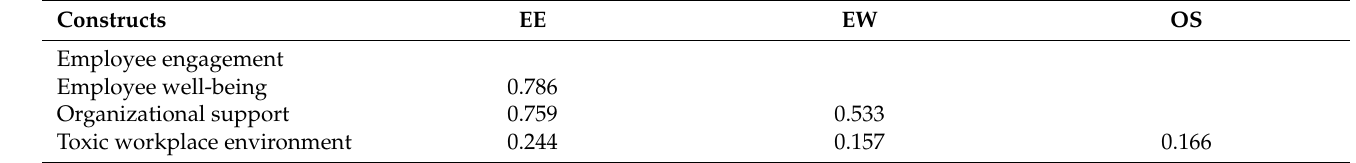
Table 3. Discriminant